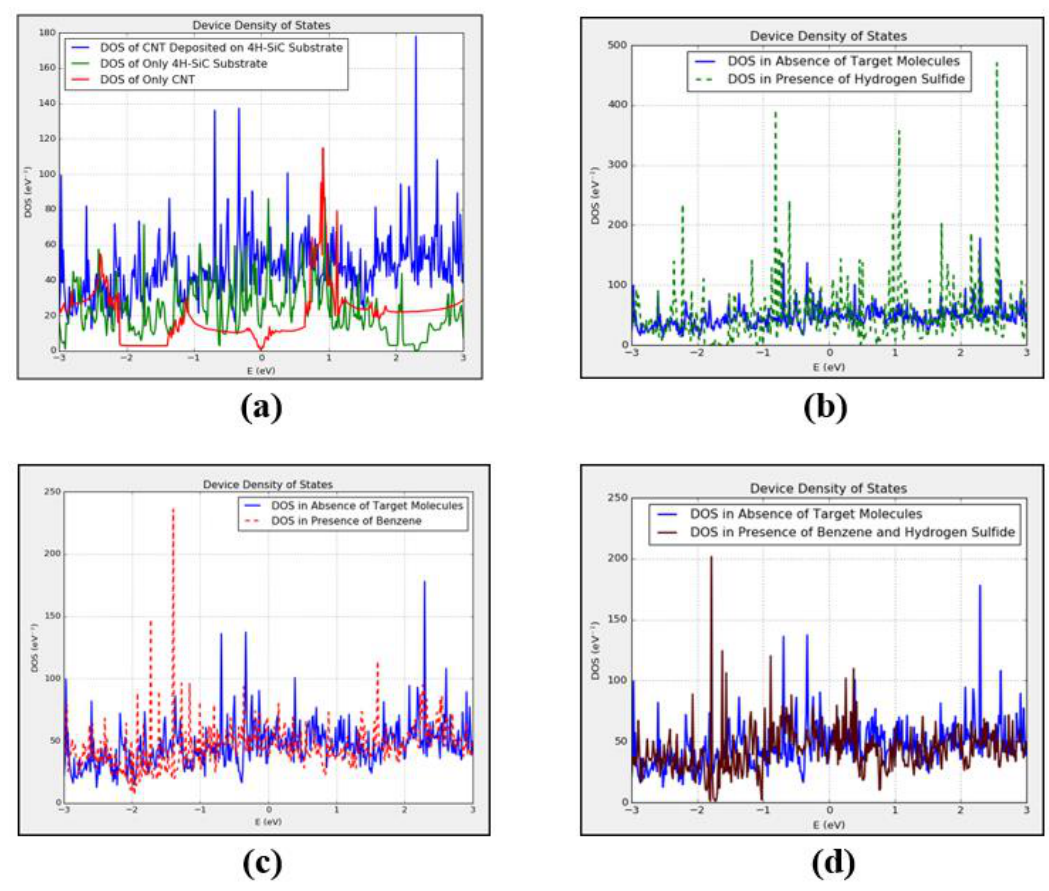
Figure 3. Density of states (DOS) of ( a ) only carbon nanotube-based device; ( b ) device in presence of only hydrogen-sulfide molecules; ( c ) device in presence of only benzene molecules; ( d ) device in presence of both hydrogen-sulfide and benzene molecules.